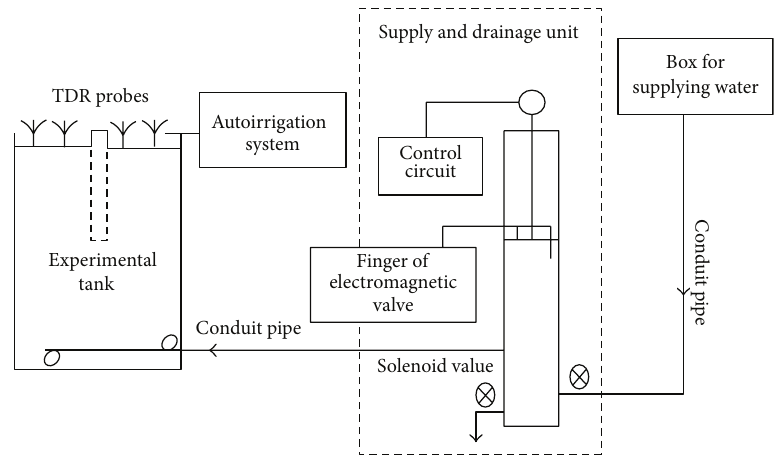
Figure 1: Schematic diagram of the experimental set-up placed in the tank. Table 1: Design of controlled irrigation and drainage (CID)